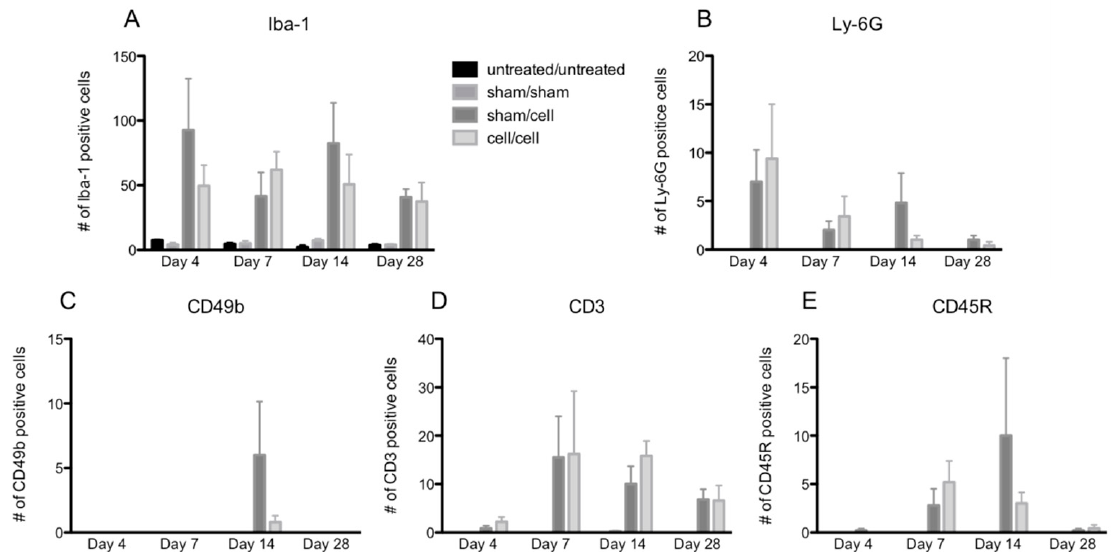
Figure 3. Quantification of immune cell infiltration following gmRPC transplantation. Infiltrated Figure 3. Quanti fi cation of immune cell in fi ltration following gmRPC transplantation. In fi ltrated immune cells were visualized as red fluorescent signals within the imaging field following gmRPC immune cells were visualized as red fl uorescent signals within the imaging fi eld following gmRPC injection for each experimental condition, counted using ImageJ, and plotted in bar graphs. injection for each experimental condition, counted using ImageJ, and plo tt ed in bar graphs. Data from Iba-1 (activated macrophage and microglia marker) ( A ), anti-Ly-6G (neutrophils marker) ( B ), anti-CD49b (natural killer cells marker) ( C ), antibodies anti-CD3 (T cells marker) ( D ), and an- ti-CD45R (B cells marker) ( E ) were displayed in the fi gure. Two-way ANOVA tests were used to test signi fi cance between the sham/cell and cell/cell groups; p values were: ( A ) p < 0.4492, ( B ) p < 0.9376, ( C ) p < 0.1190, ( D ) p < 0.6411, and ( E ) p < 0.7201 (none were signi fi cant).